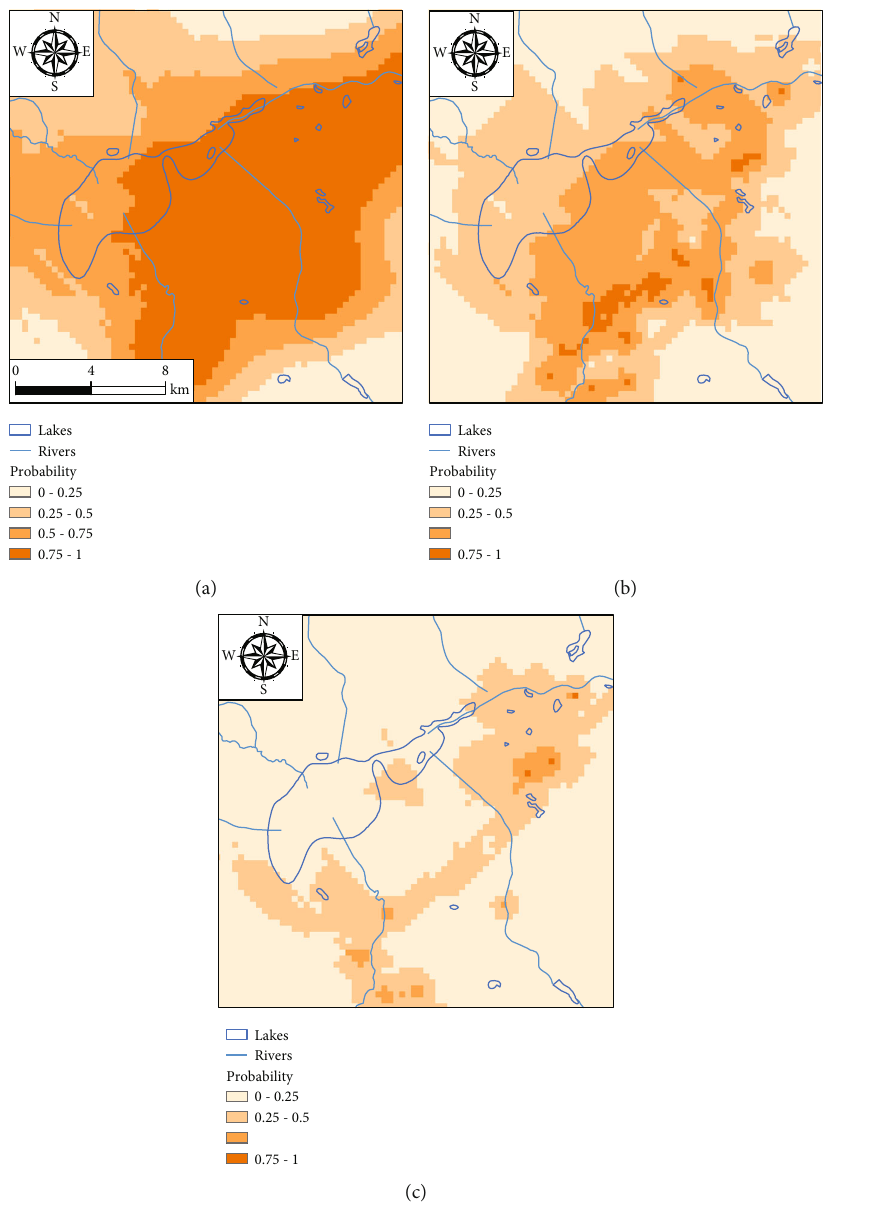
Figure 9: Probability spatial distribution of groundwater TDS under di ff erent thresholds: (a) 2.0g/L; (b) 3.0g/L; (c)